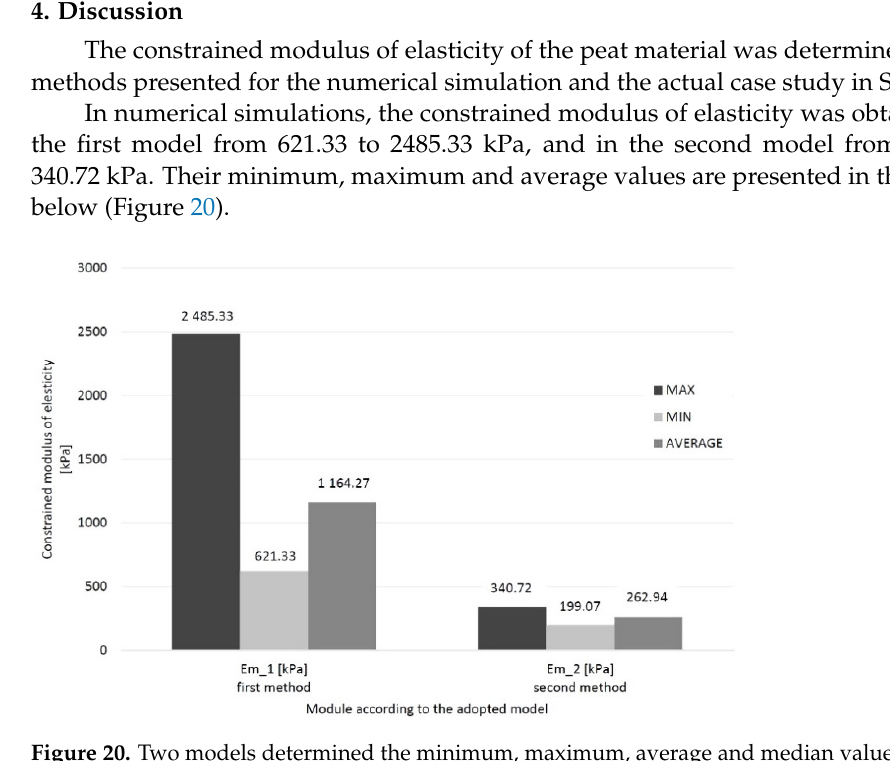
Figure 20. Two models determined the minimum, maximum, average and median values of the peat material constrained modulus of elasticity.